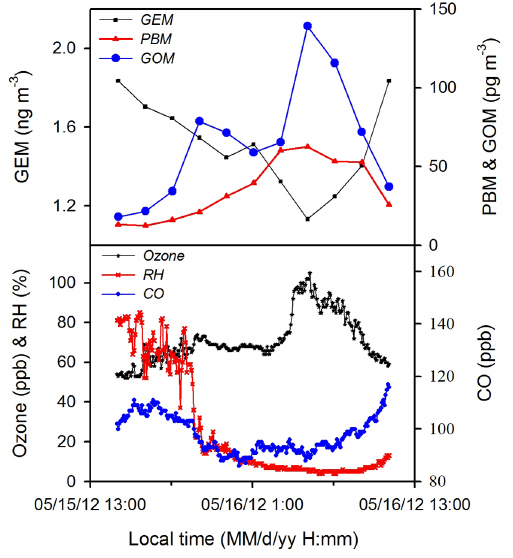
Figure 5. Time series of GEM, PBM, GOM, ozone, CO, and rela- tive humidity (RH) during high GOM event #7.